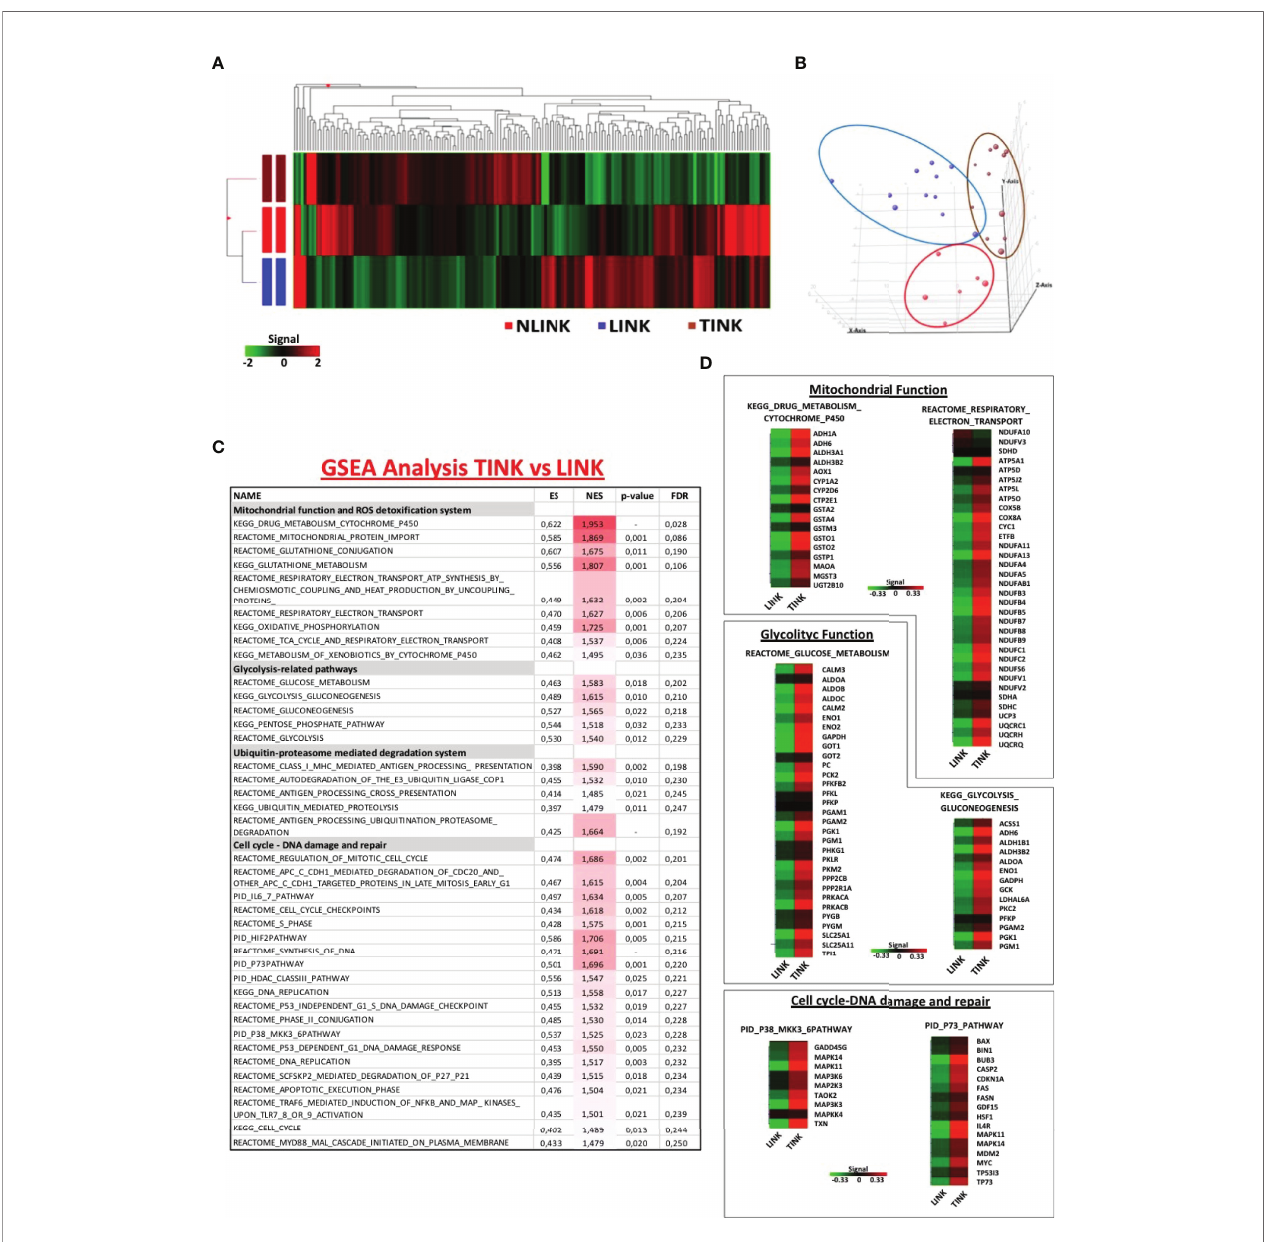
FIGURE 1 | Gene expression pattern of in fi ltrating NK cells. (A) Hierarchical clustering representation of the 181 genes identi fi ed as differentially expressed in tumor- in fi ltrating NK cells (TINK, n = 11), surrounding liver-in fi ltrating NK cells (LINK, n = 11), and normal liver-in fi ltrating NK cells (NLINK, n = 7) by ANOVA with Benjamini – Hochberg correction ( p ≤ 0.05). Data were median-normalized before clustering; upregulated and downregulated genes are shown in red and green, respectively. (B) Principal component analysis of ANOVA- fi ltered data. (C) Enriched gene sets in TINK and LINK identi fi ed by Gene Set Enrichment Analysis (GSEA; MSigDB, C2 canonical pathways). NES, normalized enrichment score; FDR, false discovery rate. (D) Heat map of differentially expressed genes derived from GSEA in TINK and LINK related to mitochondrial and glycolytic function, cell cycle, and DNA damage/DNA repair. The upregulated genes are presented in red and the downregulated genes in